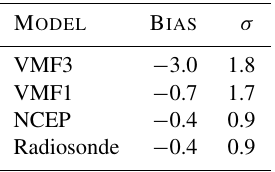
Table 1. Bias and standard deviation in zenith hydrostatic delay (cid:49)L z (mm) between the reference solution from in situ pressure h measurements and the other solutions. M